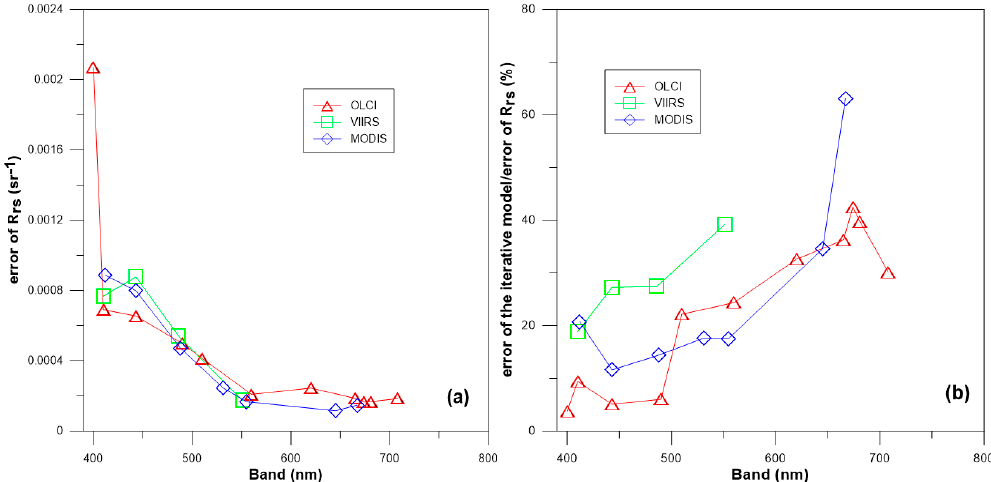
Figure 10. Mean error of R rs from OLCI, MODIS, and VIIRS in open ocean ( a ) and the mean percentage of the error of the iterative model in the error of R rs from OLCI, MODIS, and VIIRS in the open ocean (SCS) ( b ).